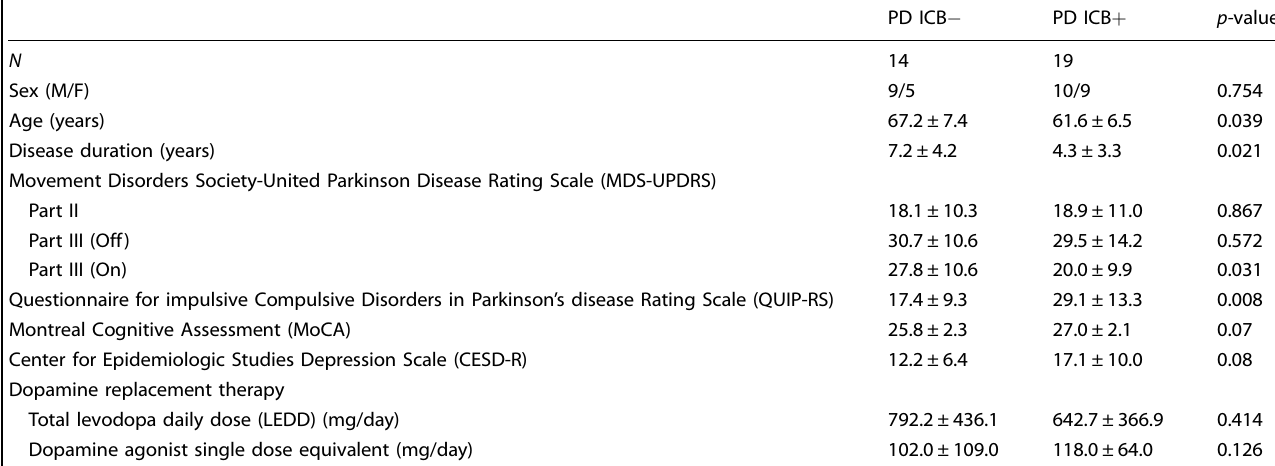
Table 1. Demographic and clinical